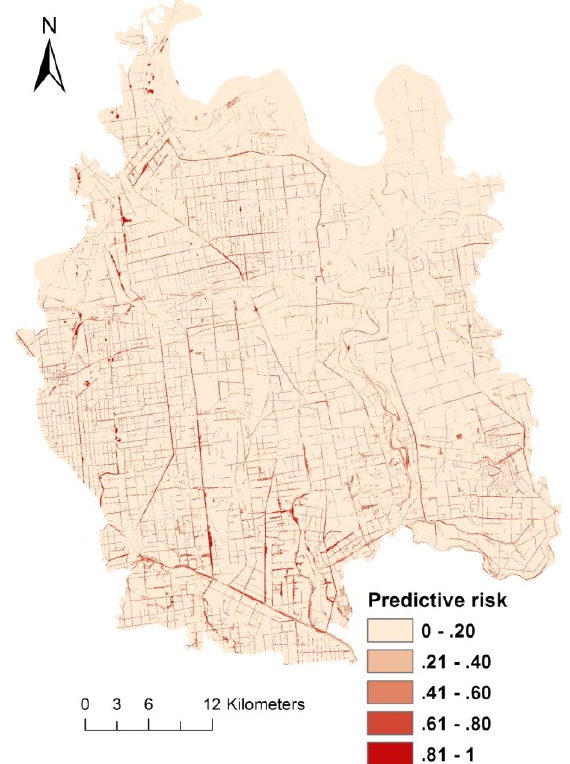
Figure 2. Predictive risk map of snail habitats in Qianjiang